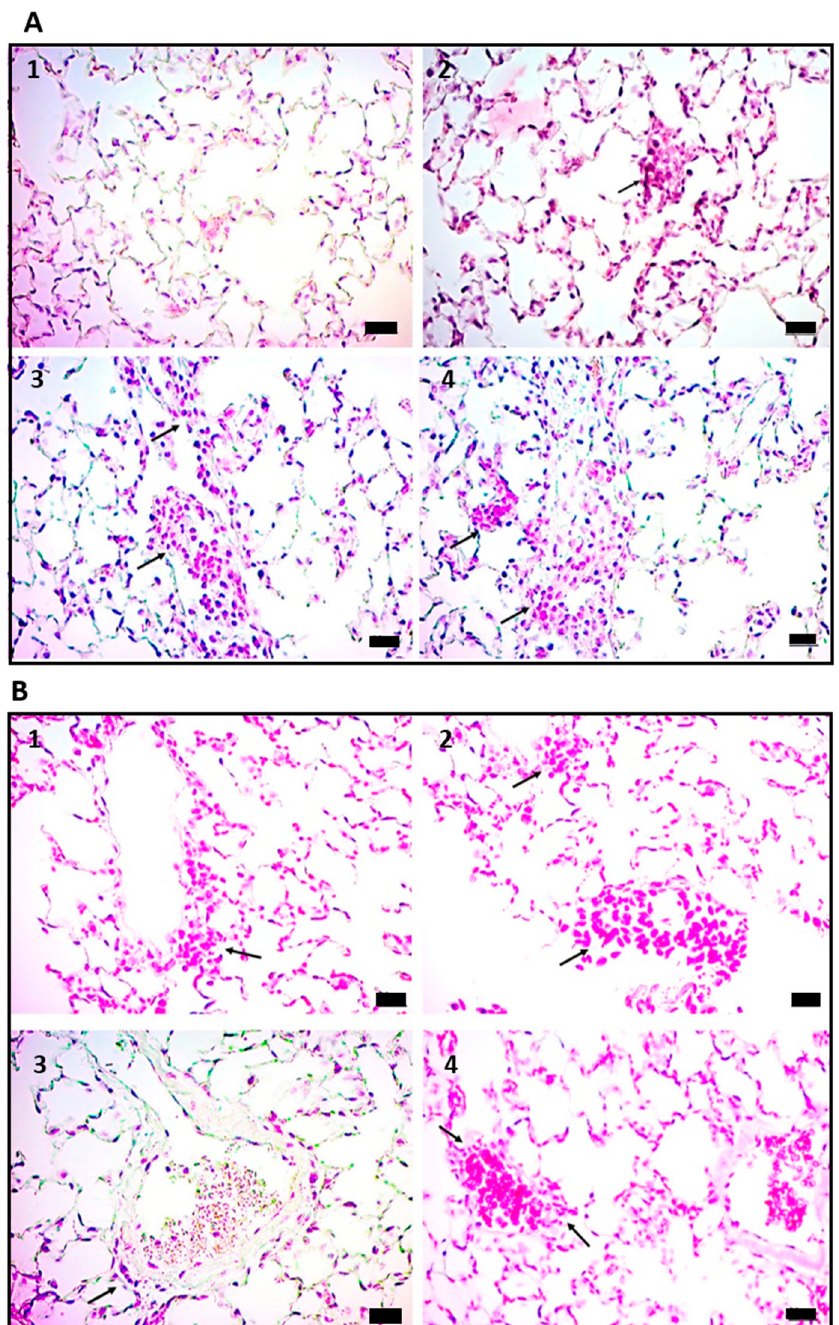
Figure 2. Histopathological features of the lung. ( A1 ) Control with normal alveoli; ( A2 ) alveolar inflammatory infiltrates with a predominance of macrophages on day 1, arrow point to small granuloma; ( A3 , A4 ) chronic perivascular inflammatory infiltrates in bronchioles and pleura on day 14, arrows mark small blood vessels with ectasia and lymphocytic inflammatory infiltrate; ( B1 , B2 ) mononuclear chronic inflammatory infiltrate-type vasculitis was marked with an arrows in peribronchiolar blood vessels on day 21; ( B3 ) vascular ectasia and vasculitis were observed on day 28, pointed with an arrow blood vessel wall thickened; ( B4 ) blood vessels with ectasia and adhesion of mononuclear inflammatory cells in the vascular wall on day 60, was signed with an arrow. Hematoxylin and eosin stain 40×. Scale bar 20 µm.